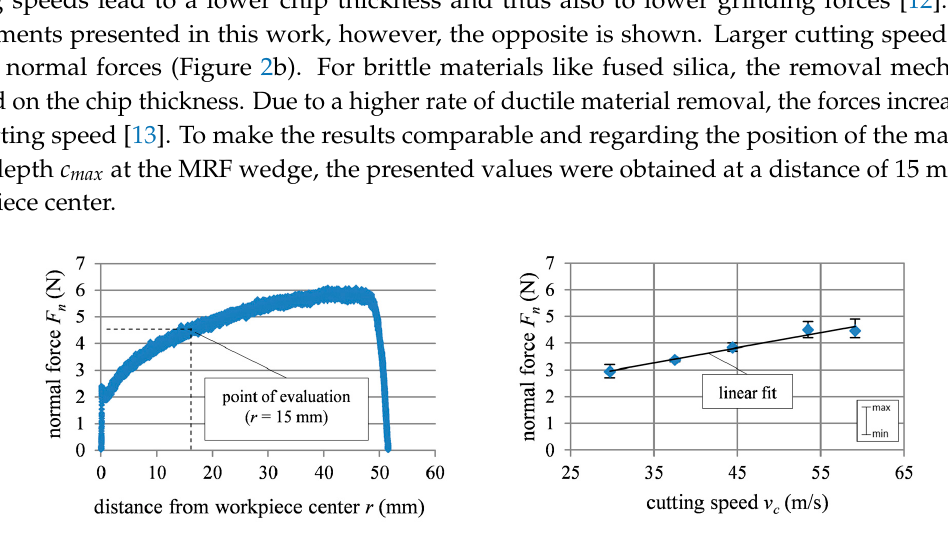
Figure 2. ( a ) Typical force curve ( F n ) at v c = 62 m/s) for constant worktable speed n W ; ( b ) Normal forces for different cutting speeds (distance from workpiece center 15 mm).